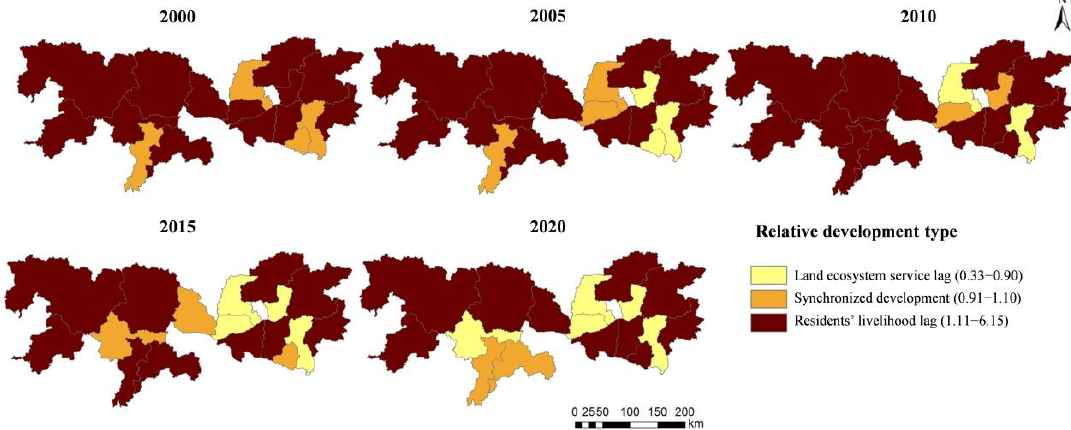
Figure 6. Spatiotemporal distribution of the relative development between residents’ livelihoods and land ecosystem services in the ORTTR of Tibet from 2000 to 2020.